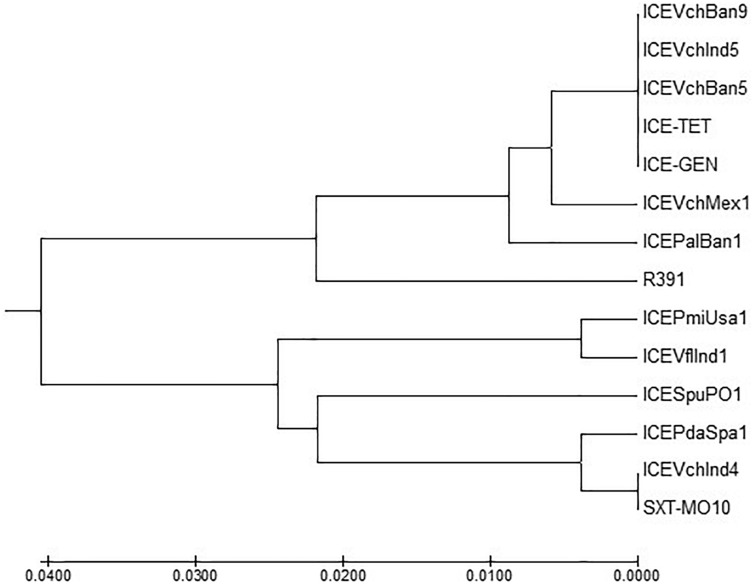
MEGA7 analysis based (Kumar et al., 2016) evolutionary relationships of taxa of eex of V. cholerae O1 strains.